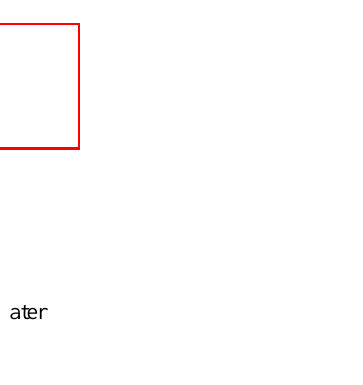
Figure 1. Examples of Two Chinese ideographs and their English